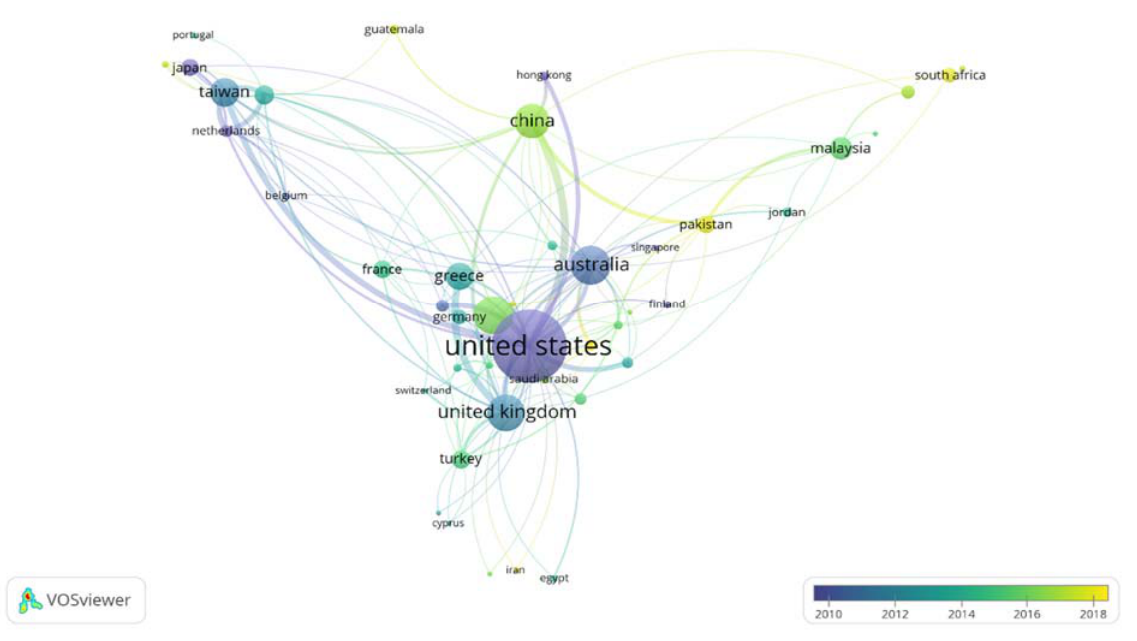
Figure 6. Overlay visualisation of country collaborations. Source: Elaborated by authors using data extracted from Scopus.